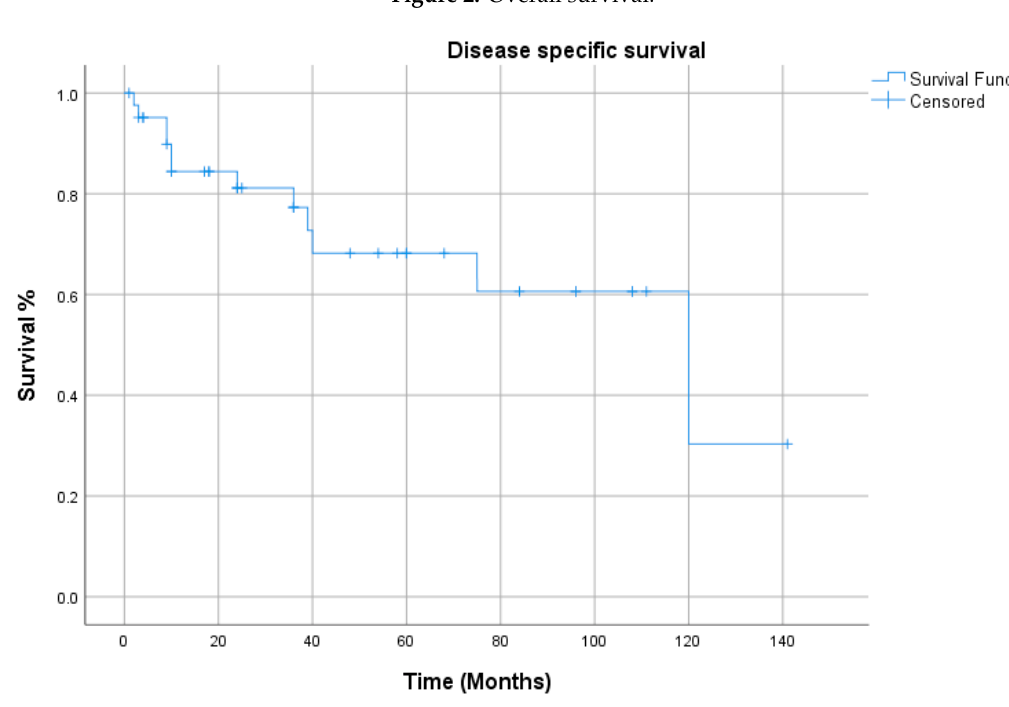
Figure 2. Overall survival.